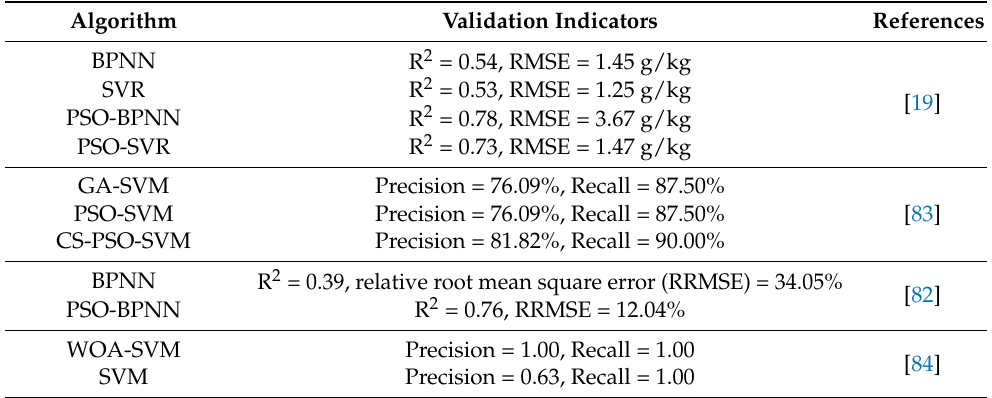
Table 4. The comparison of inversion accuracy of algorithms among different studies.